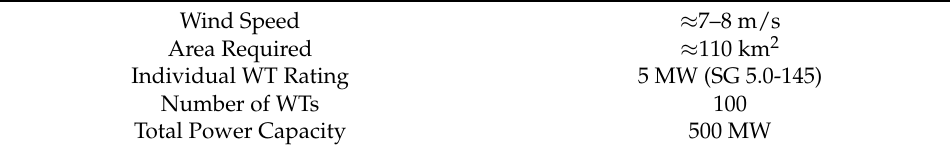
Table 6. Specs of the onshore wind farm for